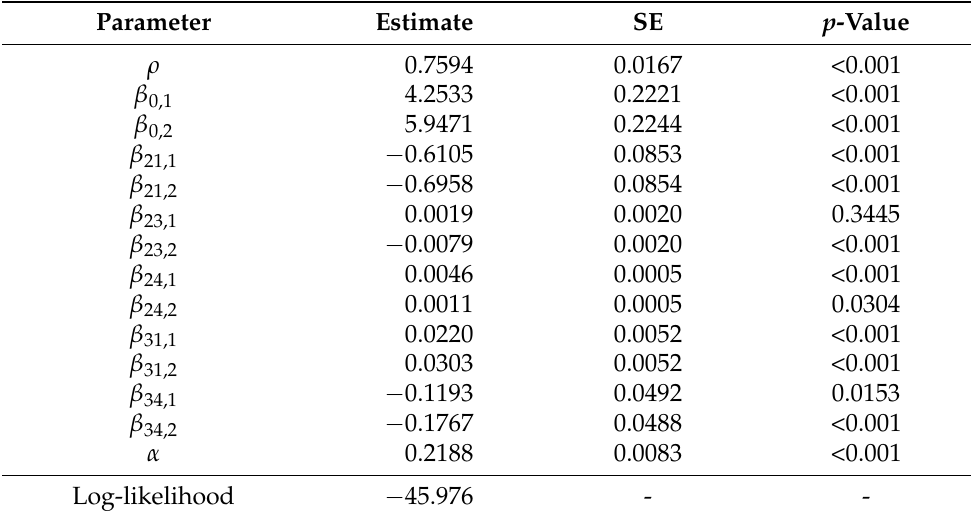
Table 5. ML estimate for the listed parameter and corresponding estimated SE, p -value and maxi- mized log-likelihood value for the BS- t model and ν = 3 using Chilean PM data.